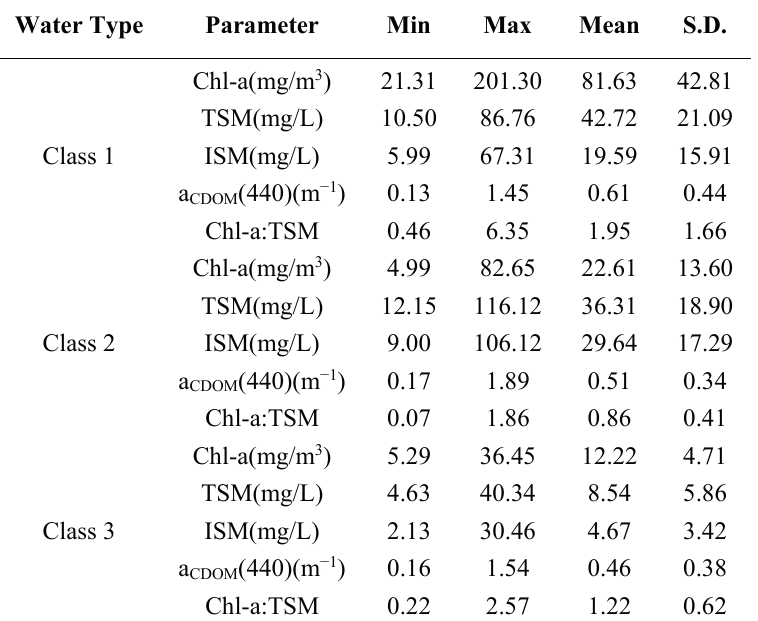
Table 2. Statistical values of water parameters for each